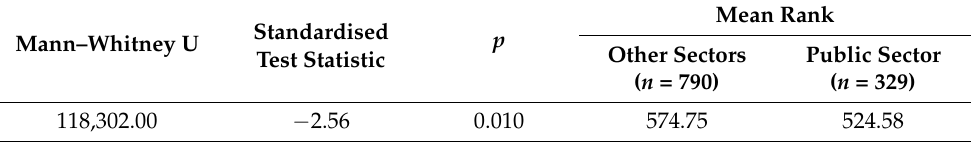
Table 4. Effect of sector on the perception of the existence of bureaucracy in the Public Administration.